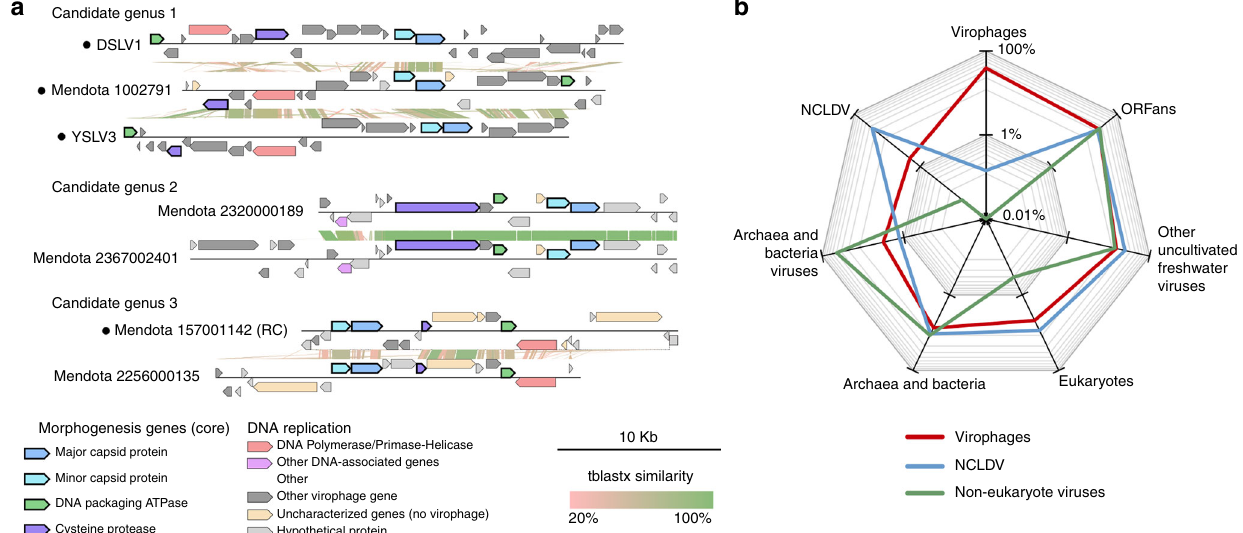
Fig. 2 Virophage genome comparison and overall gene content. a Comparison of assembled genomes from the three new candidate virophage genera proposed. Tblastx similarities are depicted between genomes within each candidate genus. Circular contigs are indicated with a black dot next to the contig name. b Gene content of newly assembled freshwater virophages. Predicted genes were fi rst af fi liated to previously published virophages, then to other viral and cellular genomes, and fi nally to other virophages assembled in Lake Mendota and Trout Bog Lake. ORFs with no signi fi cant similarity to any database were considered ORFan. DSLV, Dishui Lake virophage; YSLV, Yellowstone Lake virophage